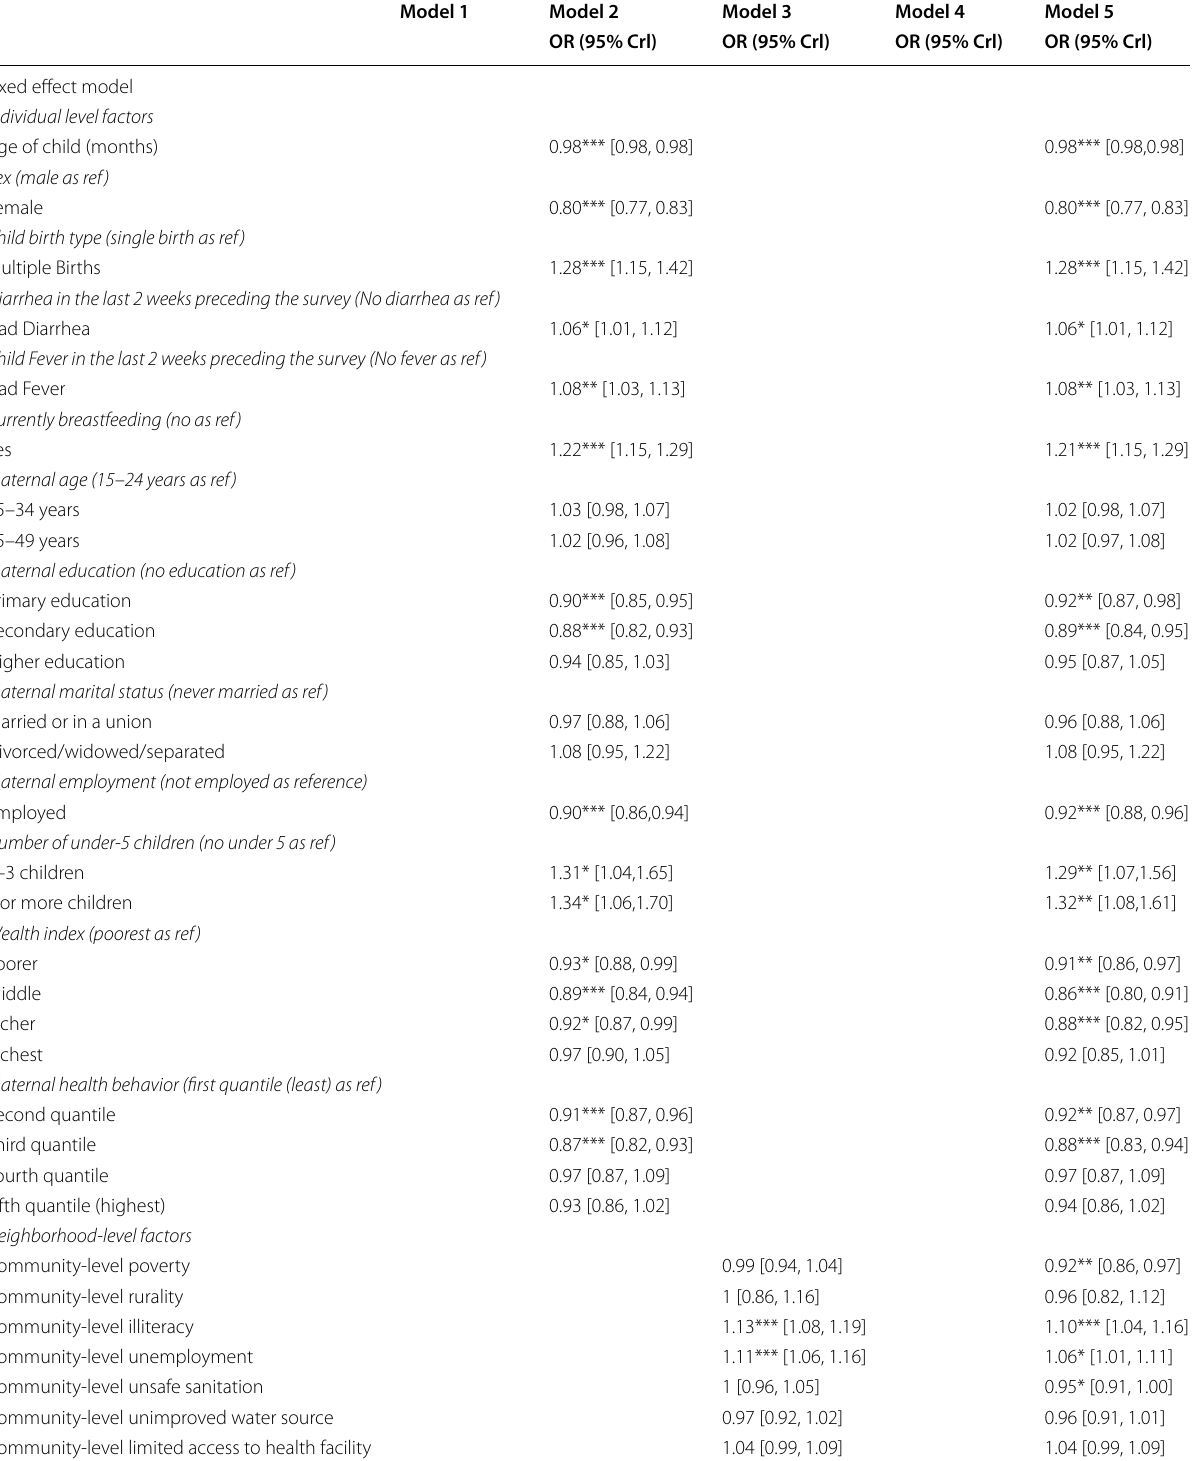
Table 3 Individual, neighborhood and country-level factors associated with the double burden of childhood malnutrition identified by multilevel logistic regression